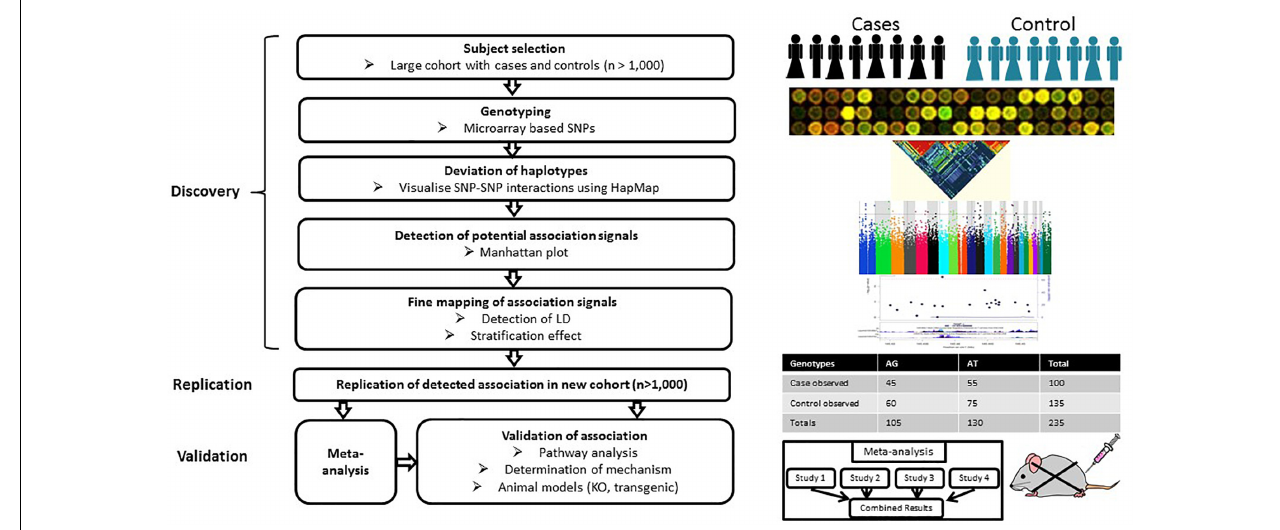
FIGURE 2 | Workflow of GWAS. A typical GWAS includes three stages: discovery, replication and validation. The discovery stage focuses on identifying associations between SNPs and traits based on a large cohort with either quantitative trait or case/control phenotype data. The second stage focuses on the replication of preliminary associations in an independent cohort. Meta-analysis can be applied to increase the statistical power of individual GWAS at this stage. The final stage focuses on the validation of the detected associations through pathway analyses, determination of mechanism or genetic manipulation in animal models.